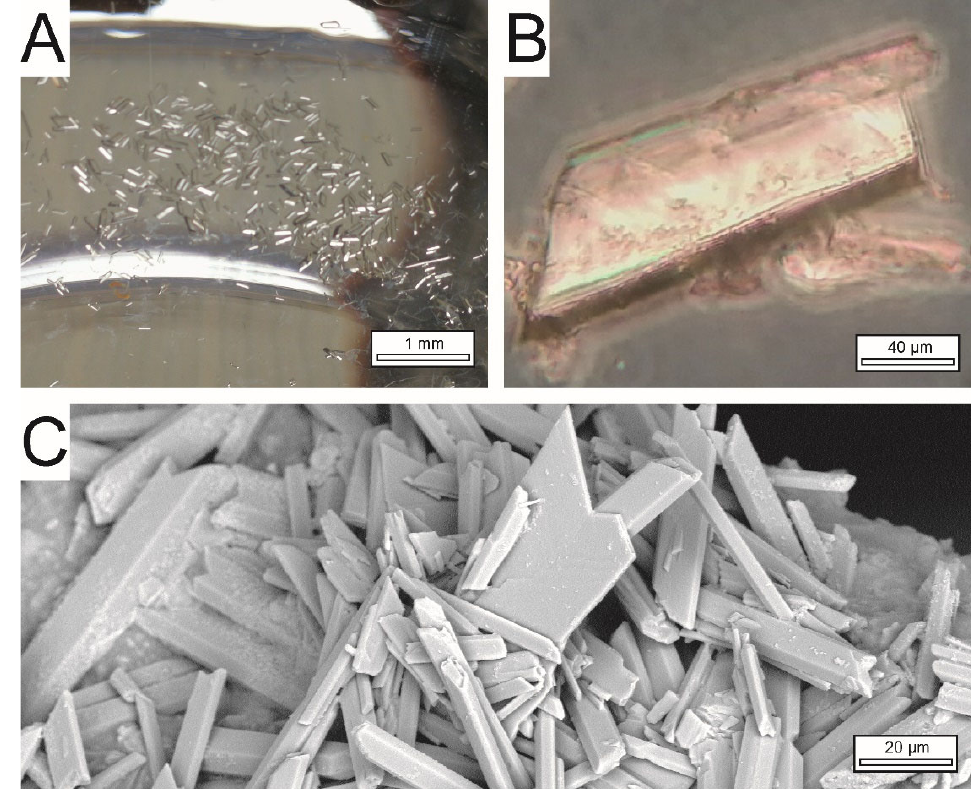
Figure 11 . A photograph ( A ) and two photomicrographs ( B , C ) of abiotic crystals obtained from the evaporation control (CGOR ‐ 1) at different scales: ( A ) macro view of the transparent gypsum crystals in its precipitation solution under glass and micro views of optical microscopy ( B ) and FE ‐ SEM ( C ). Crystals are c ‐ axis ‐ elongated with very sharp edges. Some of them are fishtail ‐ twinned in (C).